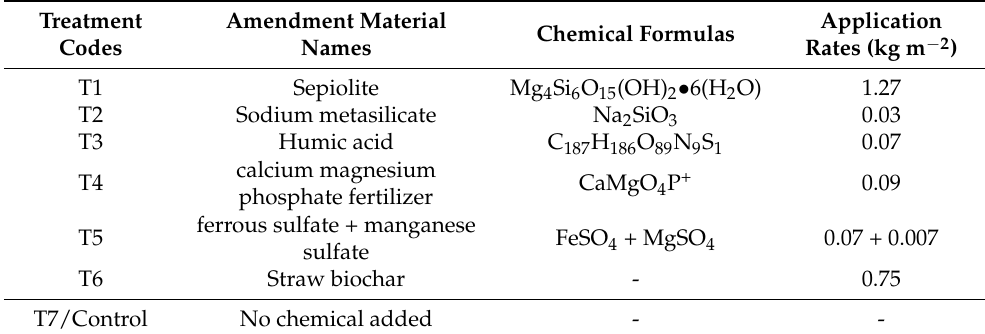
Table 1. The name, codes, chemical formulas, and application rates amendments of different amend- ment materials used in the small-scale field